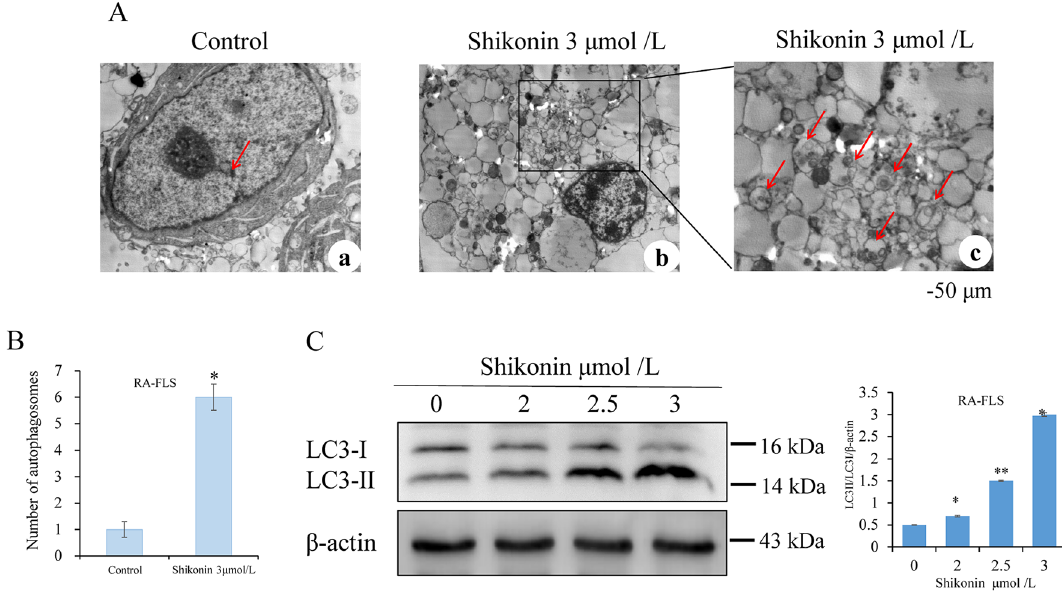
Figure 4. Shikonin induces autophagy in RA-FLS cells. ( A , B ) Transmission electron microscopy shows submicroscopic structures associated with autophagy in RA-FLSs from the control group and the shikonin group after 24 h of treatment with shikonin. ( C ) Western blot showing protein levels of LC3. Scale bar represents 50 μm. Data are representative of at least three independent experiments. *p < 0.05, **p < 0.01 vs control